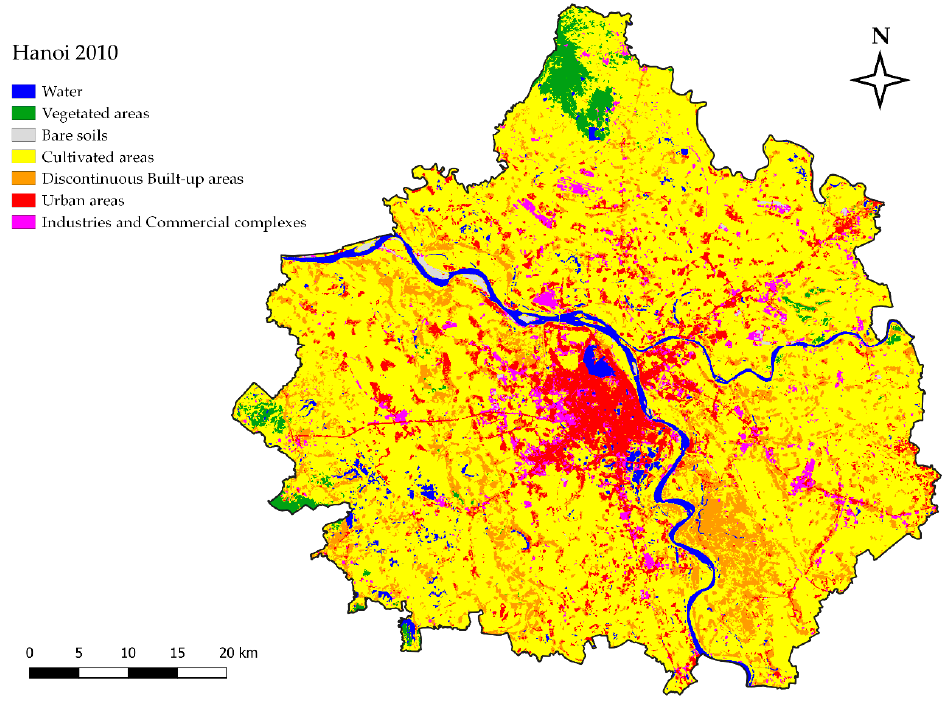
Figure 8. The 2010 LULC map of the study area.